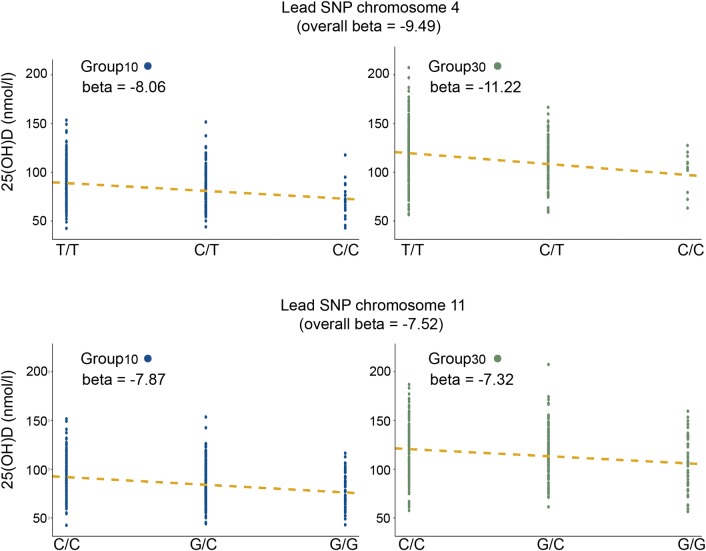
Association statistics for Group10 vs Group30.The analysis focuses on the lead SNPs at each significantly associated locus while separating the randomization groups. The results show that the lead SNP on chromosome 4 (rs1155563) seem to have a larger effect in the group receiving 30 μg of daily vitamin D (Group30) than in the group receiving 10 μg (Group10). The lead SNP on chromosome 11 (rs10832310) instead displayed a similar effect size regardless of randomization group, suggesting that the locus on chromosome 4 can modulate supplementation response, while the locus on chromosome 11 does not. Y-axis is 25(OH)D at 24 months.